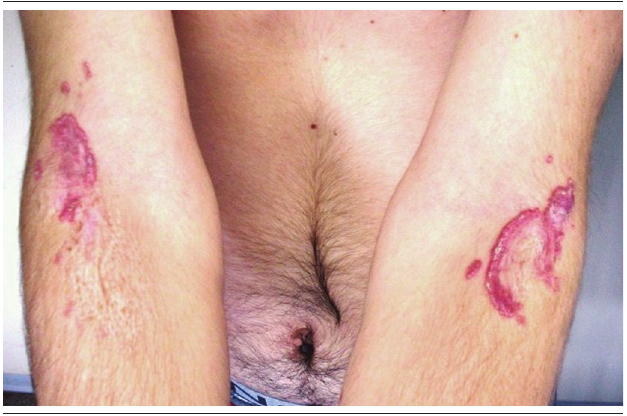
FigurE 1 − Circular, arciform and serpiginous lesions in antecubital regions